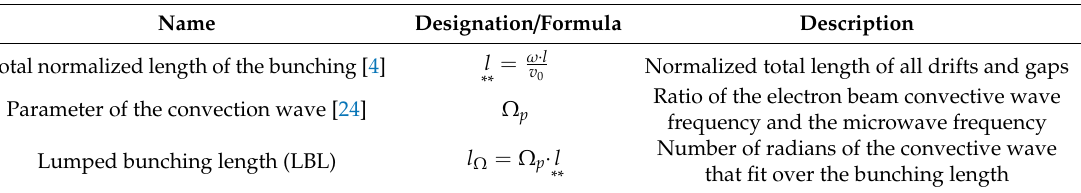
Table 5. Bunching dimensionless values.